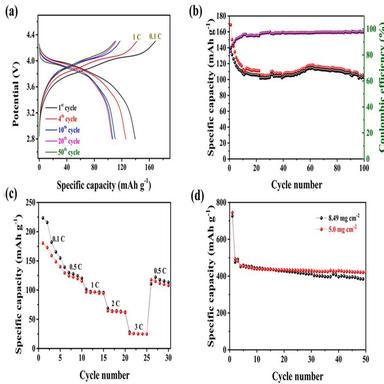
(a) Charging/discharging curves for different cycles; (b) Cycling performance at 1 C and (c) Rate performance of the g-Si/CNTs-Gr//NCM811 full cell; (d) Discharge performance of the g-Si/CNTs-Gr electrode with different loaded amounts.